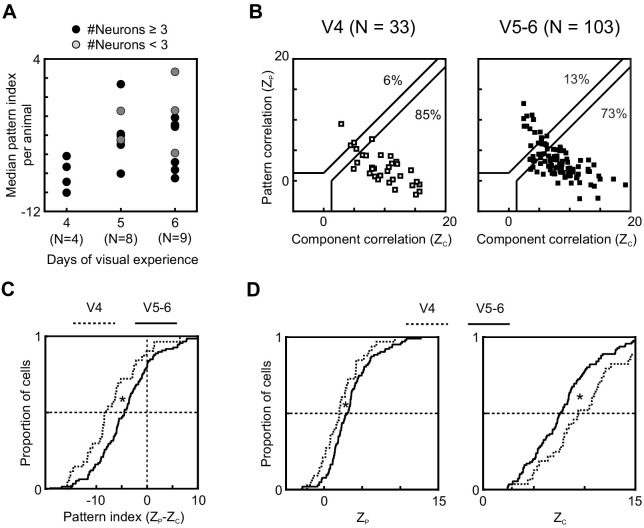
Longer visual experience results in a higher degree of PSS motion integration.(A) Median PSS pattern index for each animal aged P37–40, plotted as a function of visual experience. Gray dots represent animals that yielded 1–2 neurons, and black dots represent animals with data for at least three neurons. (B) Pattern versus component correlations at P37–40 split according to visual experience (same plot format as Figure 2C). (Left) Animals with 4 days of visual experience. (Right) Animals with 5–6 days of visual experience. (C) Cumulative distributions of pattern indices for PSS cells in kits with 4 days (V4, dashed line) or 5–6 days (V5-6, solid line) of visual experience. *p<0.05. (D) Cumulative distributions for component correlation (left) and pattern correlation (right) for the two groups. *p<0.05.Figure 3—source data 1.Neuron-by-neuron metrics for Figure 3.